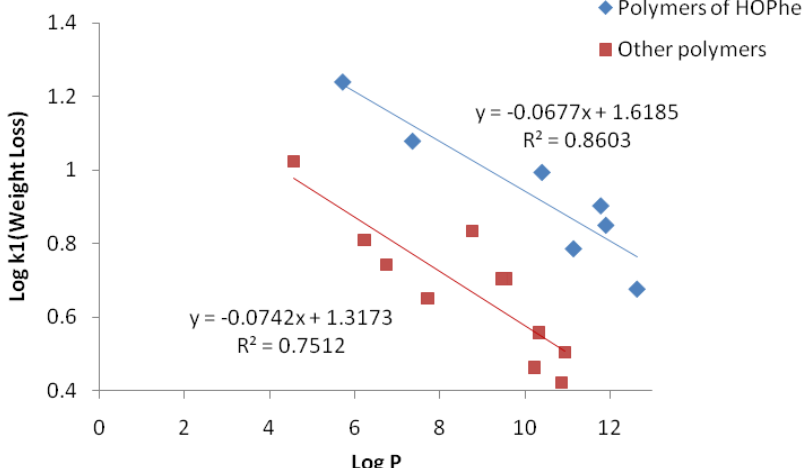
and Log P for the two sets of 1